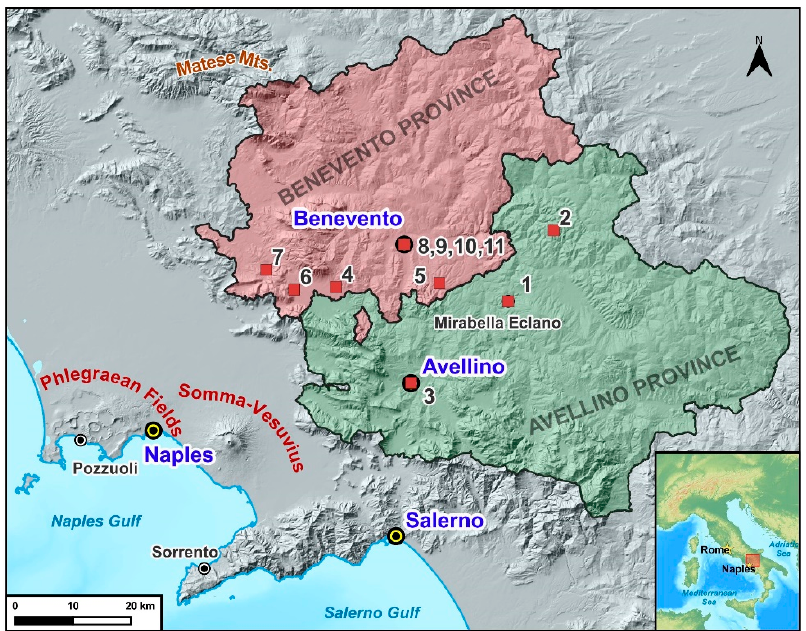
Figure 1. Location and denomination of the schools of the provinces of Benevento (BN) and Avellino (AV) which collaborated with UNISANNIO for the realization of the PNG. (1) Higher Institute “Ae- clanum” (Mirabella Eclano, AV); (2) Institute of Higher Secondary Education “Ruggero II” (Ariano Irpino, AV); (3) State Scientific High School “P.S. Mancini “(Avellino); (4) “Enrico Fermi” Higher Education Institute (Montesarchio, BN); (5) “Virgilio” Higher Education Institute (S. Giorgio del Sannio, BN); (6) Higher Education Institute “A. Lombardi “(Airola, BN); (7) Higher Education Insti- tute “S. Alfonso Maria dè Liguori “(Sant’Agata dei Goti, BN); (8) State scientific high school “G. Rummo”(Benevento); (9) Institute of Higher Education “G. Alberti ”(Benevento); (10) Liceo and Magistrale Institute “G. Guacci “(Benevento); (11) Institute of Higher Education “Galilei-Vetrone” (Benevento).